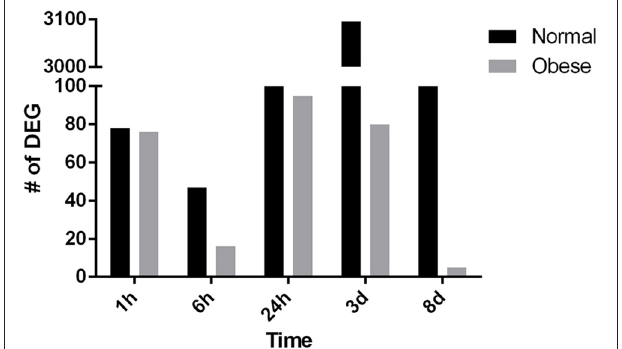
FIGURE 4 | Differentially expressed genes in normal weight and obese mice respectively ( p ≤ 0.05; fold change ≥ ± 1.5).